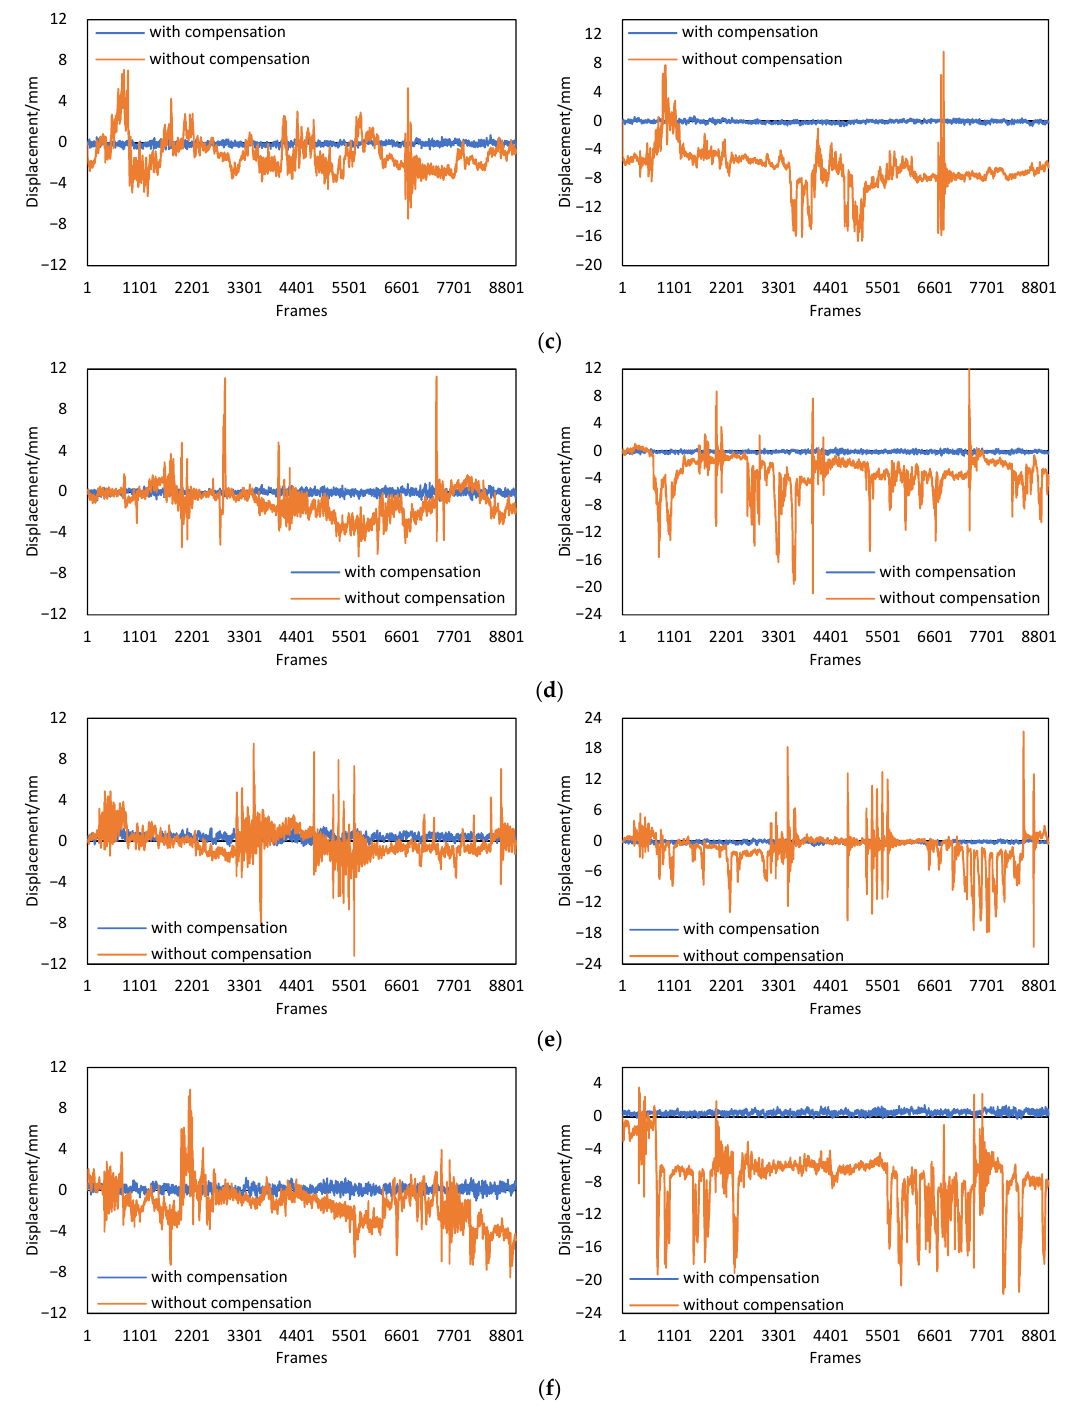
Figure 14. Displacement results of target 3 in the 𝑥 (left column) direction and 𝑦 (right column) direction. ( a ) 𝑑 = 50 m, 𝐿 = 20 m. ( b ) 𝑑 = 50 m, 𝐿 = 40 m. ( c ) 𝑑 = 50 m, 𝐿 = 80 m. ( d ) 𝑑 = 80 m, 𝐿 = 20 m. ( e ) 𝑑 = 80 m, 𝐿 = 40 m. ( f ) 𝑑 = 80 m, 𝐿 = 80 m.